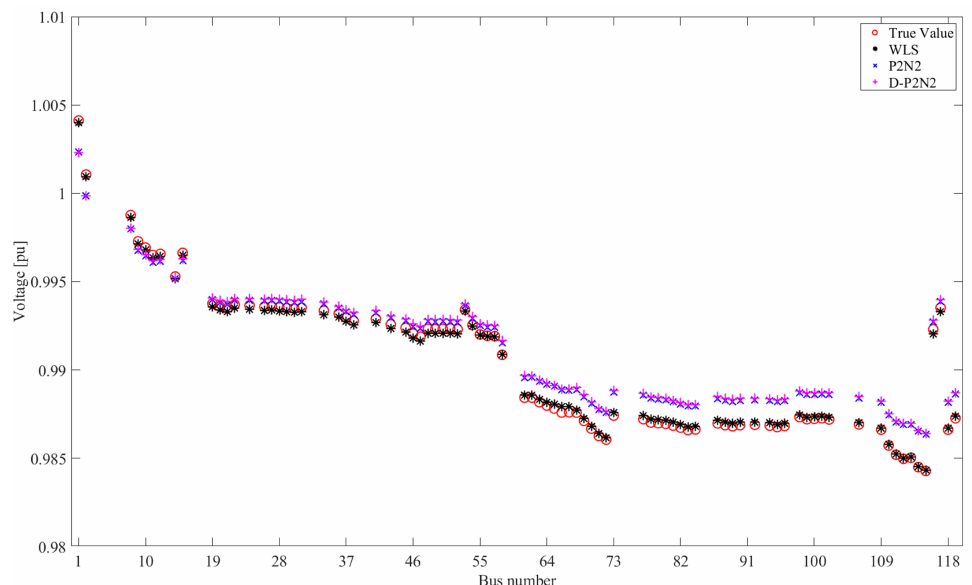
Figure 9. Estimated voltage magnitude at Phase A in Scenario 1.